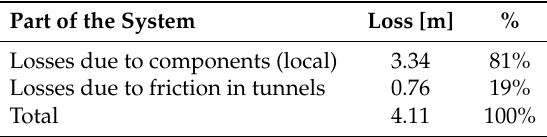
Table 2. Head losses for the new intake